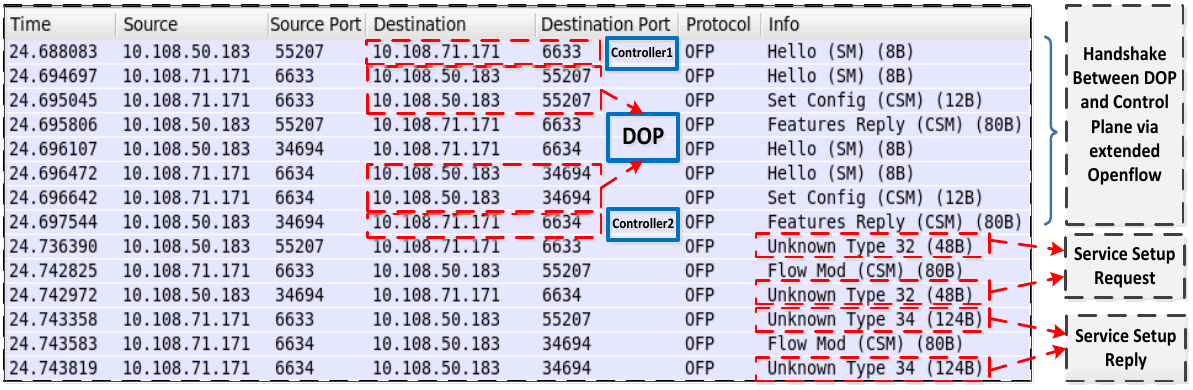
Figure 3. Wireshark capture of the signal processing for the UML